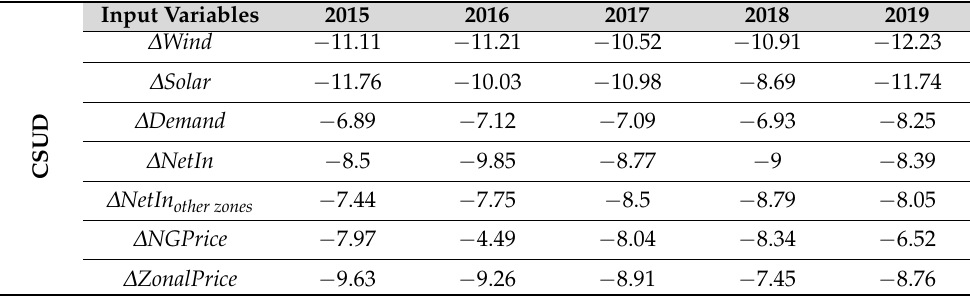
Table A2. Augmented Dickey–Fuller test statistics in 1st difference; CSUD.